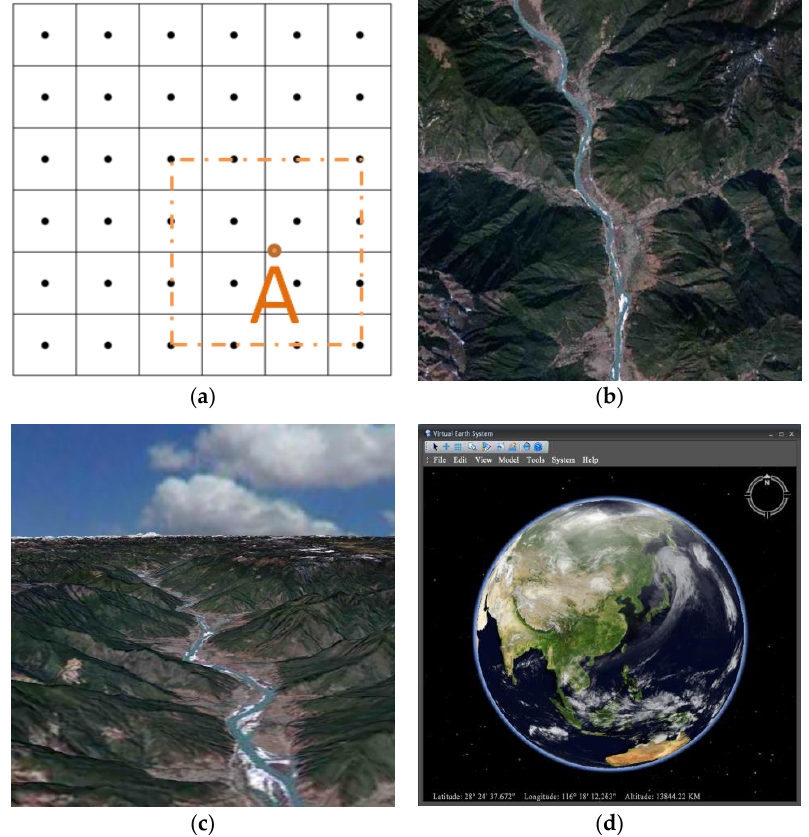
Figure 2. ( a ) Description of regular grid DEM; ( b ) DOM data; ( c ) DEM and DOM data visualization; ( d ) Virtual globe platform.